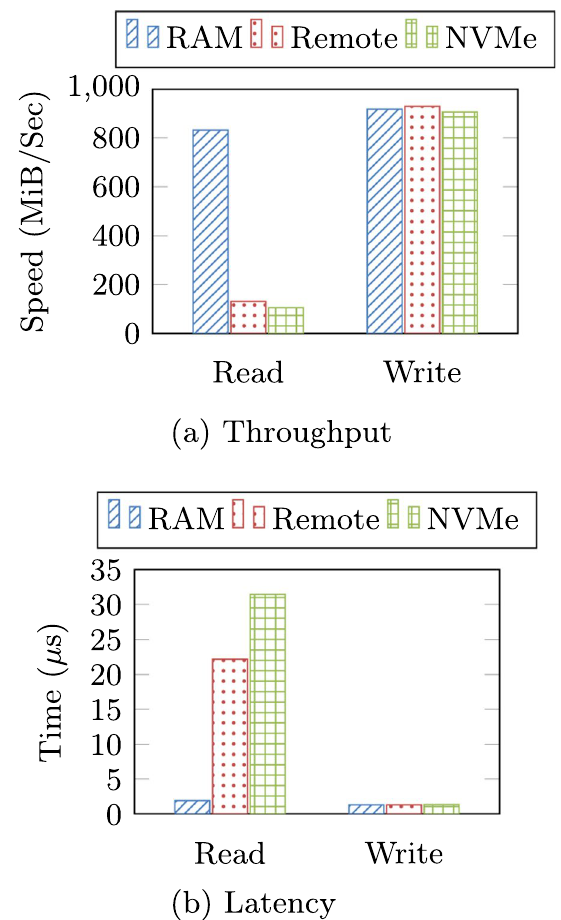
Fig. 11 The performance of random read and write operations on the 4K‑buffer block I/O